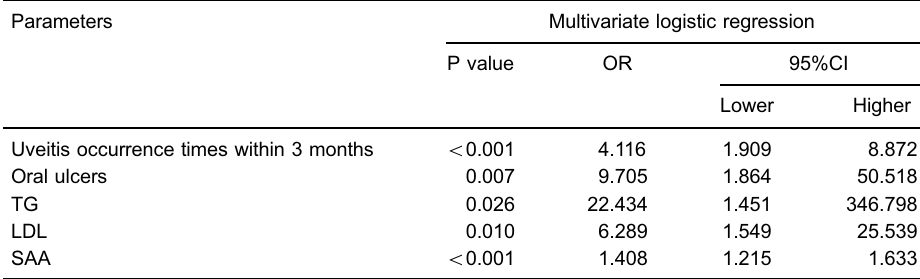
Table 3. Forward stepwise (conditional) multivariate logistic regression analysis of factors affecting anterior uveitis